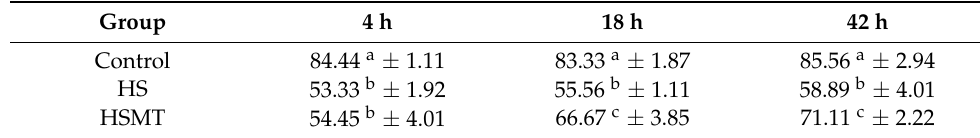
Figure 3. Effect of heat stress (HS) and melatonin on expression of HSP70 , NRF2 , CDK1 and GDF9 mRNA in the porcine oocytes during in vitro maturation (IVM). ( A ): effect of HS and melatonin on the oocytes during IVM at 4 h; ( B ): effect of HS and melatonin on the oocytes during IVM at 18 h; C : effect of HS and melatonin on the oocytes during IVM at 42 h. Different letters: a,b in the different patterned columns represent significant difference ( p < 0.05).